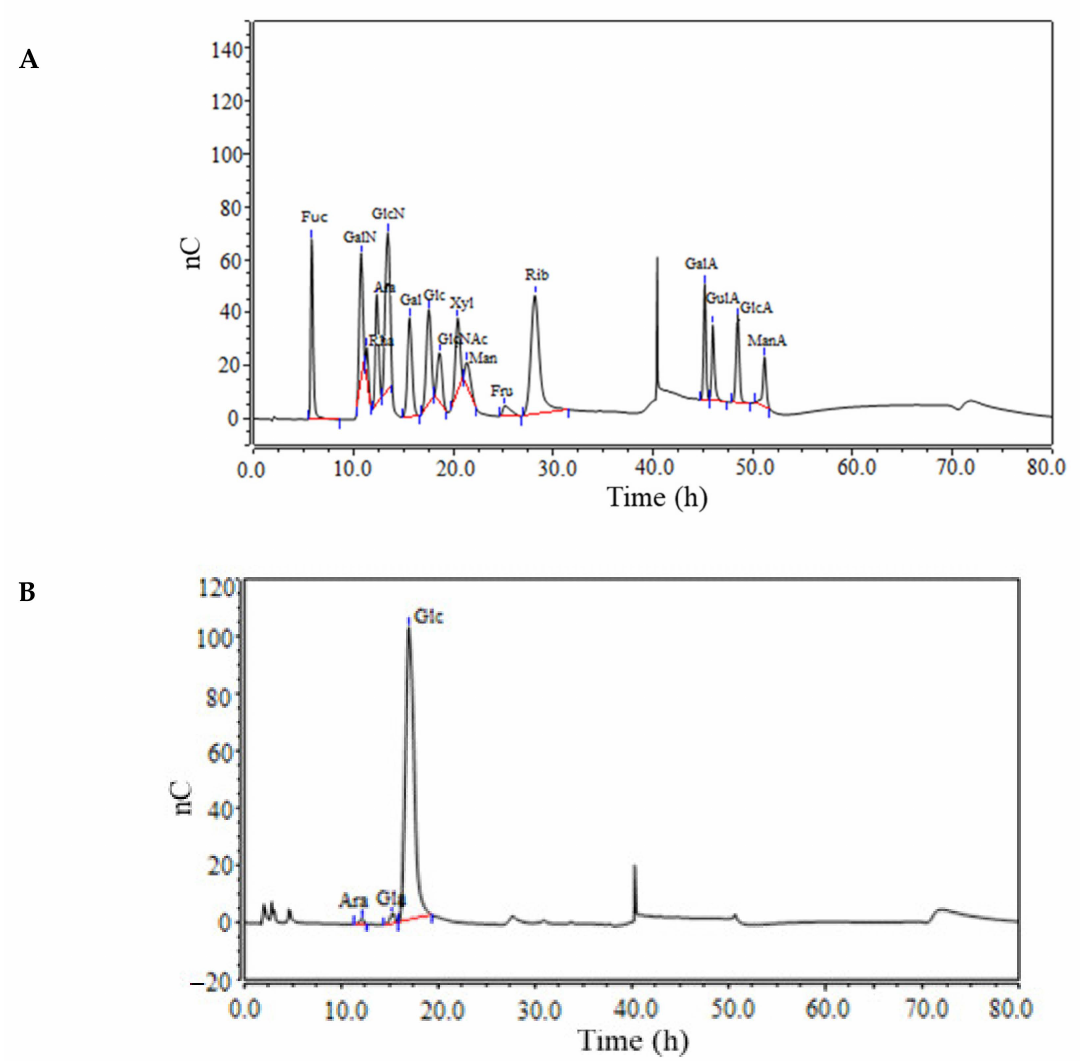
Figure 2. Monosaccharide composition of NPPc. Chromatograms of standard mixture of 15 monosaccharides ( A ) and the composed monosaccharides in NPPc ( B